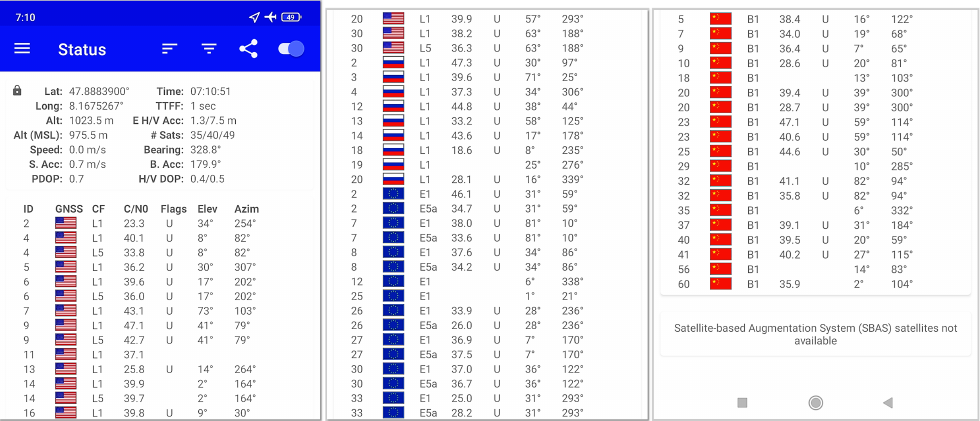
Figure 4. Example smartphone GNSS data from the Android app ’GPStest’ used for capturing and live control of the GNSS data in this